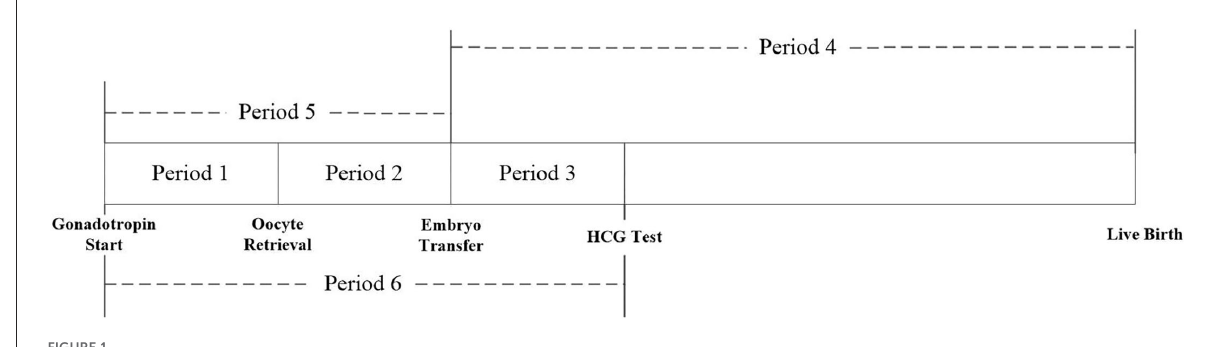
FIGURE1 Timeline of IVF stage defined for this